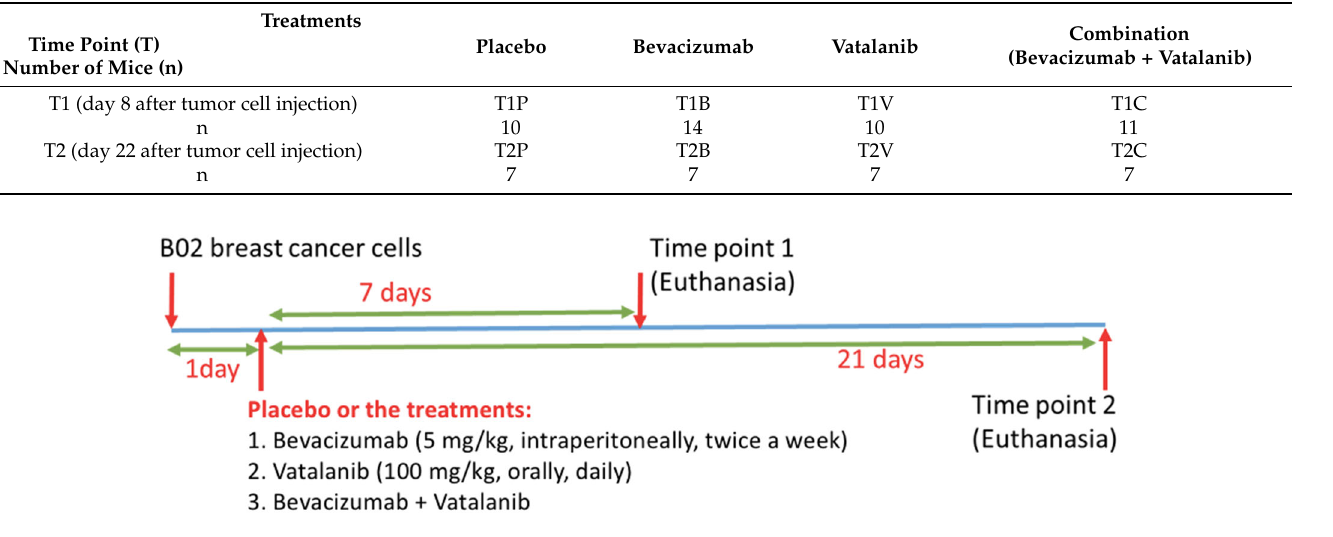
Figure 1. Summary of the treatment protocols for anti-angiogenic drugs in the mouse model of human B02 breast cancer metastasis to bone. One day after tumor cell inoculation, eight-week-old female Balb/c nude mice were treated with bevacizumab, vatalanib, a combination of both drugs, or the placebo. Animals were then sacrificed either 8 or 22 days after tumor cell inoculation.